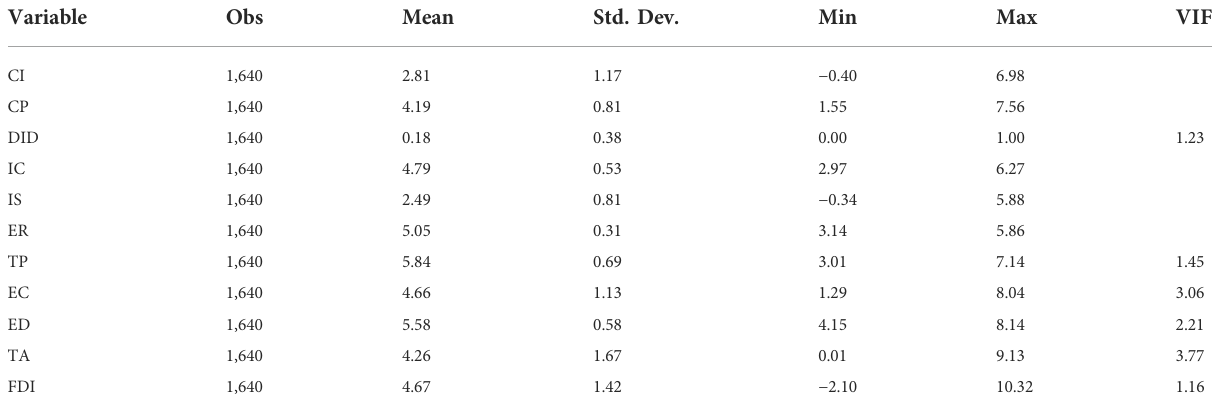
TABLE A1 Pilot and non-pilot areas of new urbanization prefecture-level cities in China. Pilot cities (59 prefecture-level)